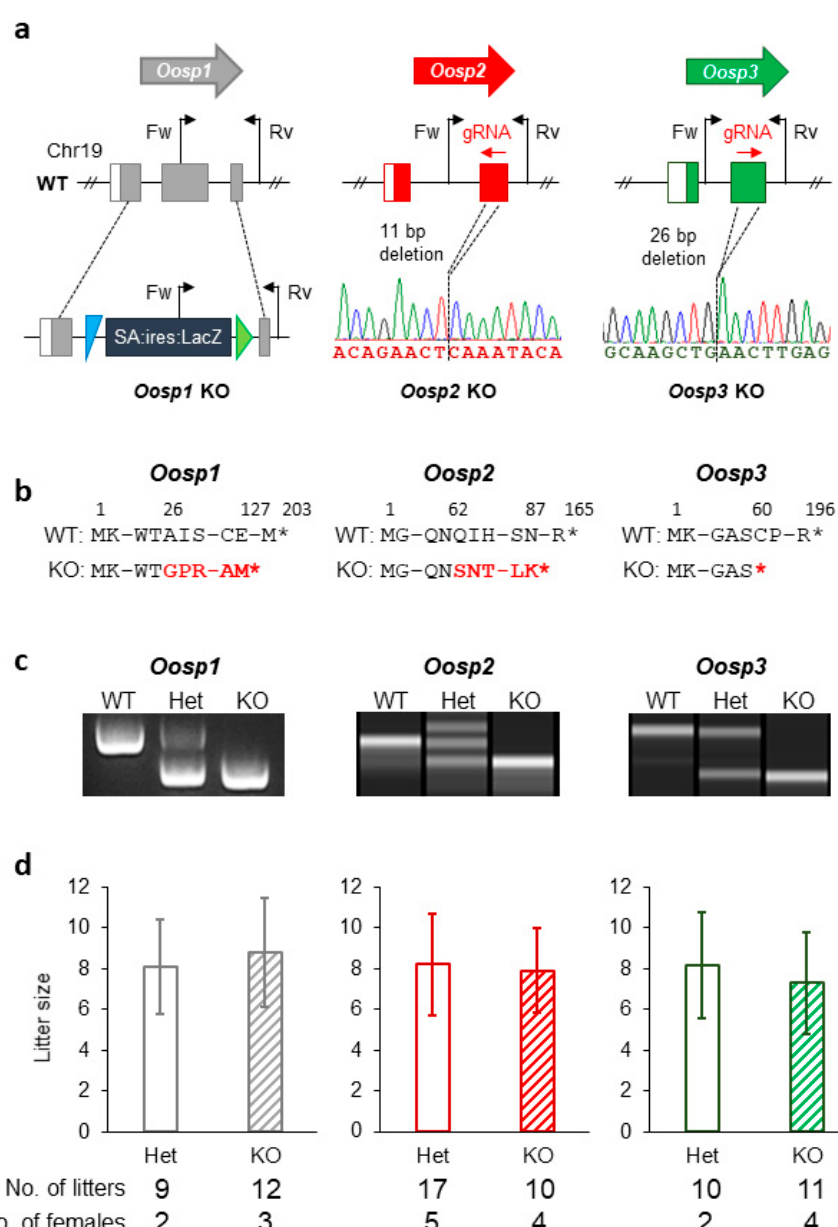
Figure 2. Generation of KO mice and their fertility analysis. ( a ) Genomic structure and KO strategy of mouse Oosp1 , Oosp2 , and Oosp3 . Black arrows: primers used for genotyping. Fw: Forward primer; Rv: Reverse Primer. Colored boxes: coding regions. WT: wild-type. ( b ) Truncated amino acid sequence. Homologous recombination in Oosp1 region induced IRES sequence instead of second exon and resulted in premature stop codon at 127 amino acid. The 11 bp deletion in the exon in Oosp2 − 11 / − 11 mice caused a Q62S mutation resulting in premature stop codon introduced 25 amino acids later. The 26 bp deletion in the exon in Oosp3 − 26 / − 26 mice caused mutation in C60 to stop codon. ( c ) Genotype verification of Oosp1 , Oosp2 , and Oosp3 KO mice by genomic PCR. WT: wild-type. ( d ) Average litter size of control and KO females.